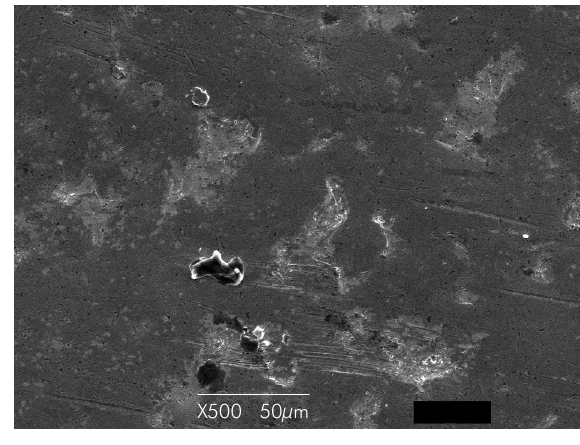
Figure 5. Photomicrograph from Group NF at 500x magnification.